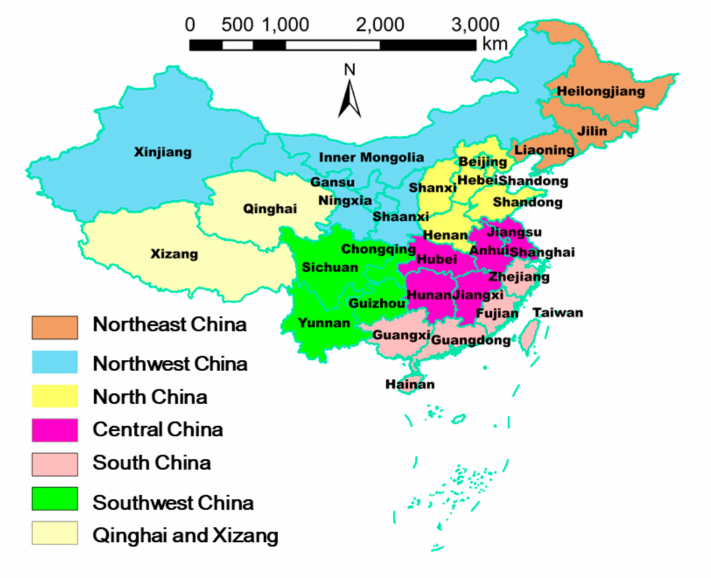
Figure 1. Geographic locations of the seven study regions in